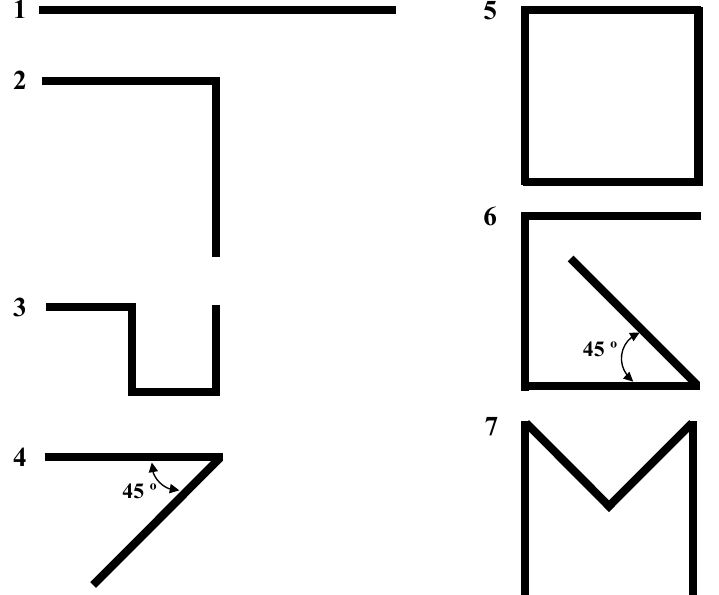
Figure 1. Electrode shapes numbered from 1 to 7, with common length L and sorted by the stretching index i s .